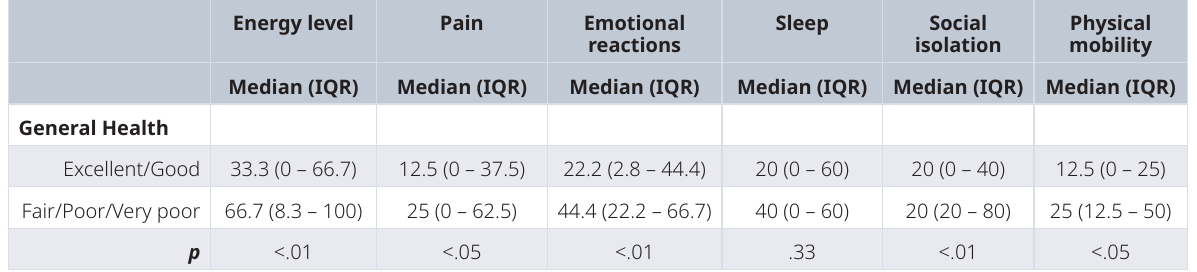
Table 6a. Median NHP section scores by perceived general health in adult Growth Hormone Deficiency